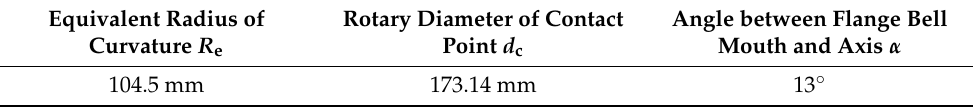
Table 3. Metal sealing gasket size